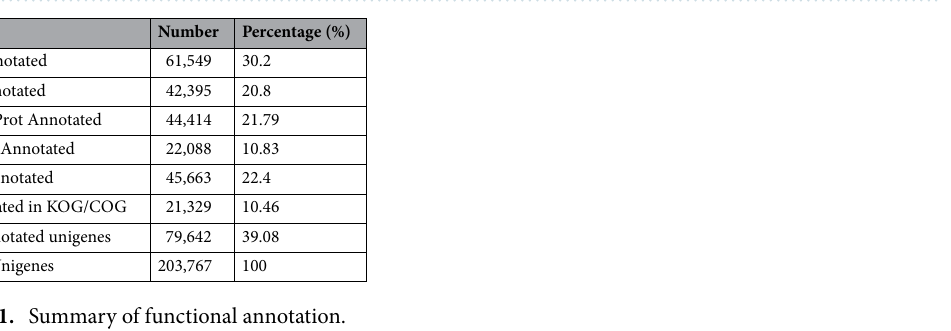
Figure 4. SOD ( A ), CAT ( B ) and POD ( C ) activities in SP and OP.